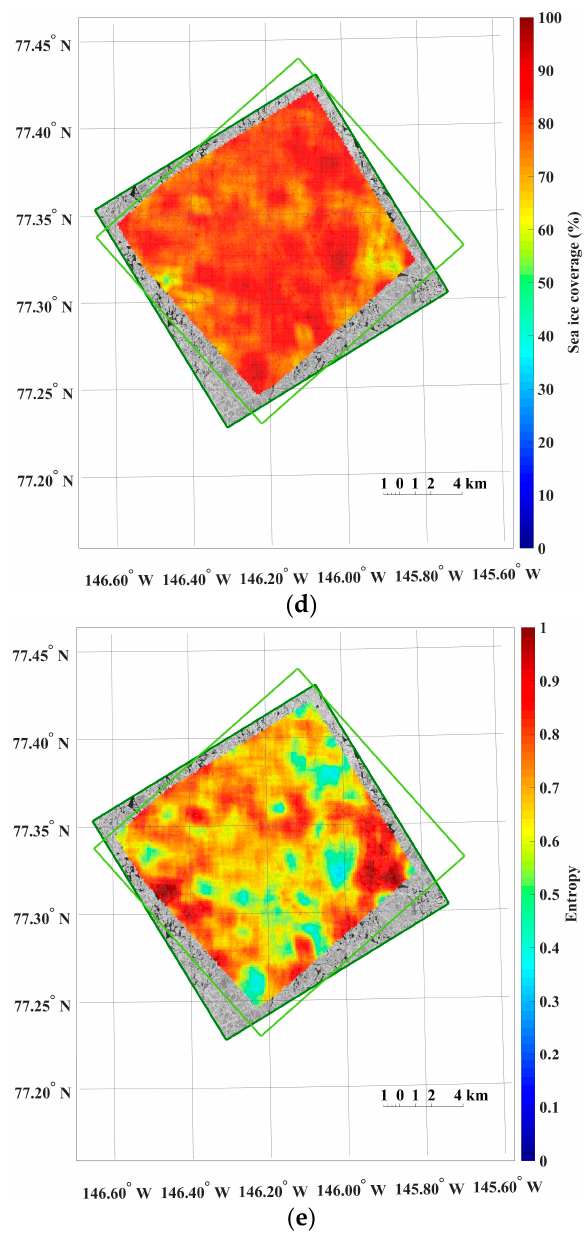
Figure 8. The results from sea ice motion measurement using the same image pair as Figure 5, resampled to the spatial resolutions of 15 m: ( a ) magnitudes of the sea ice motion vectors; ( b ) directions (headings) of the sea ice motion vectors, measured counterclockwise from east; ( c ) cross-correlation coefficient of each image block; ( d ) sea ice coverage of each image block in the prior image; and ( e ) entropy of each image block in the prior image, plotted only for the image blocks after applying the cross-correlation coefficient threshold without additional outlier removal.